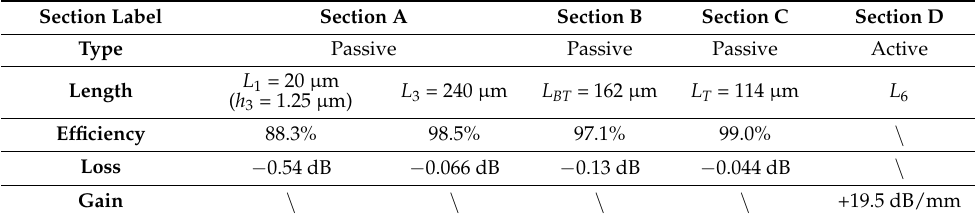
Table 4. Exemplary length for each section and the estimated optical loss at each